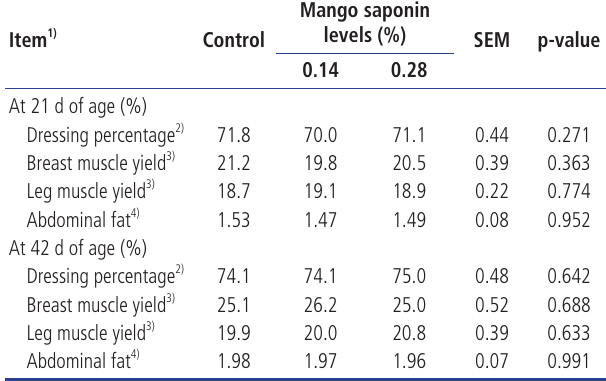
Table 3. Effect of dietary mango saponin supplementation on carcass characteristics of broiler chicks